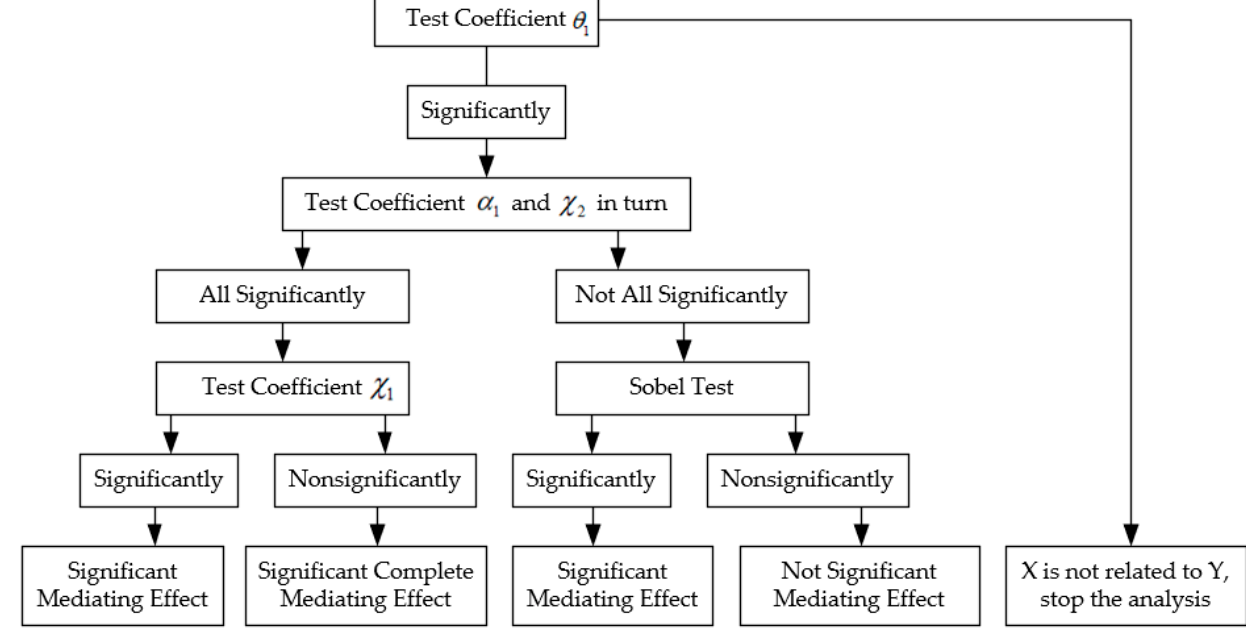
Figure 2. Mediation Effect Test Program.